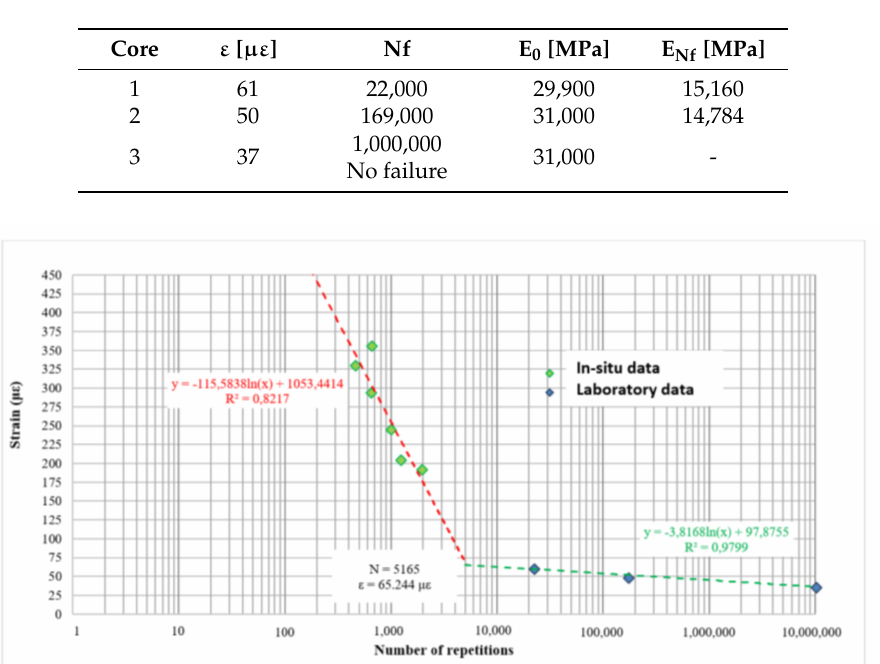
Table 8. Laboratory IT-CY test results on the cores taken from field.